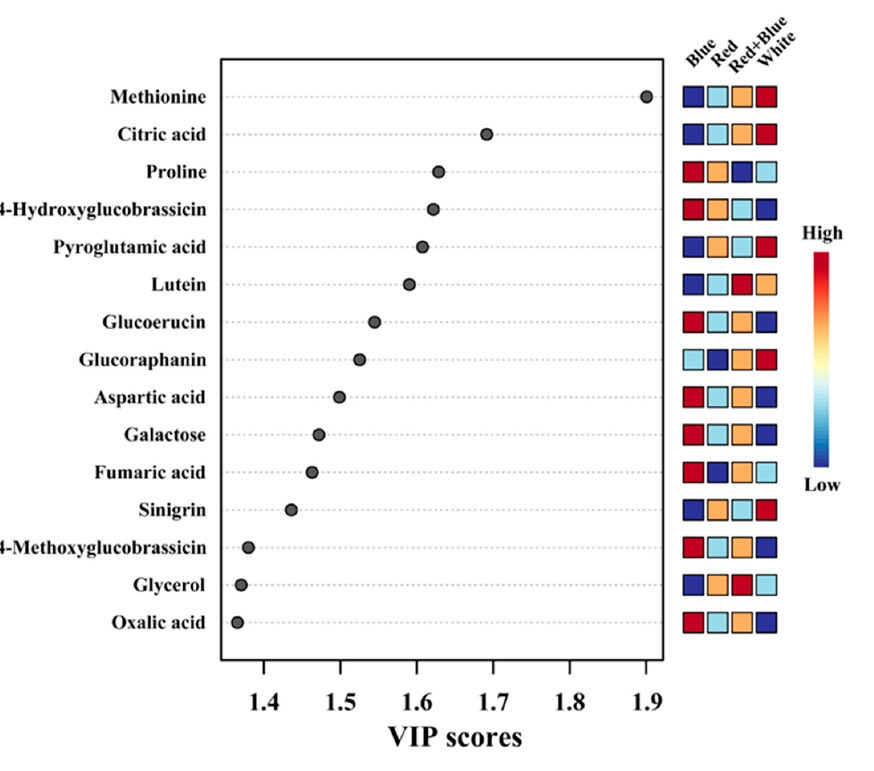
Figure 10. The main components, separating the kohlrabi sprouts after exposure to different LED light conditions, are based on the VIP scores attained through the PLS-DA model.